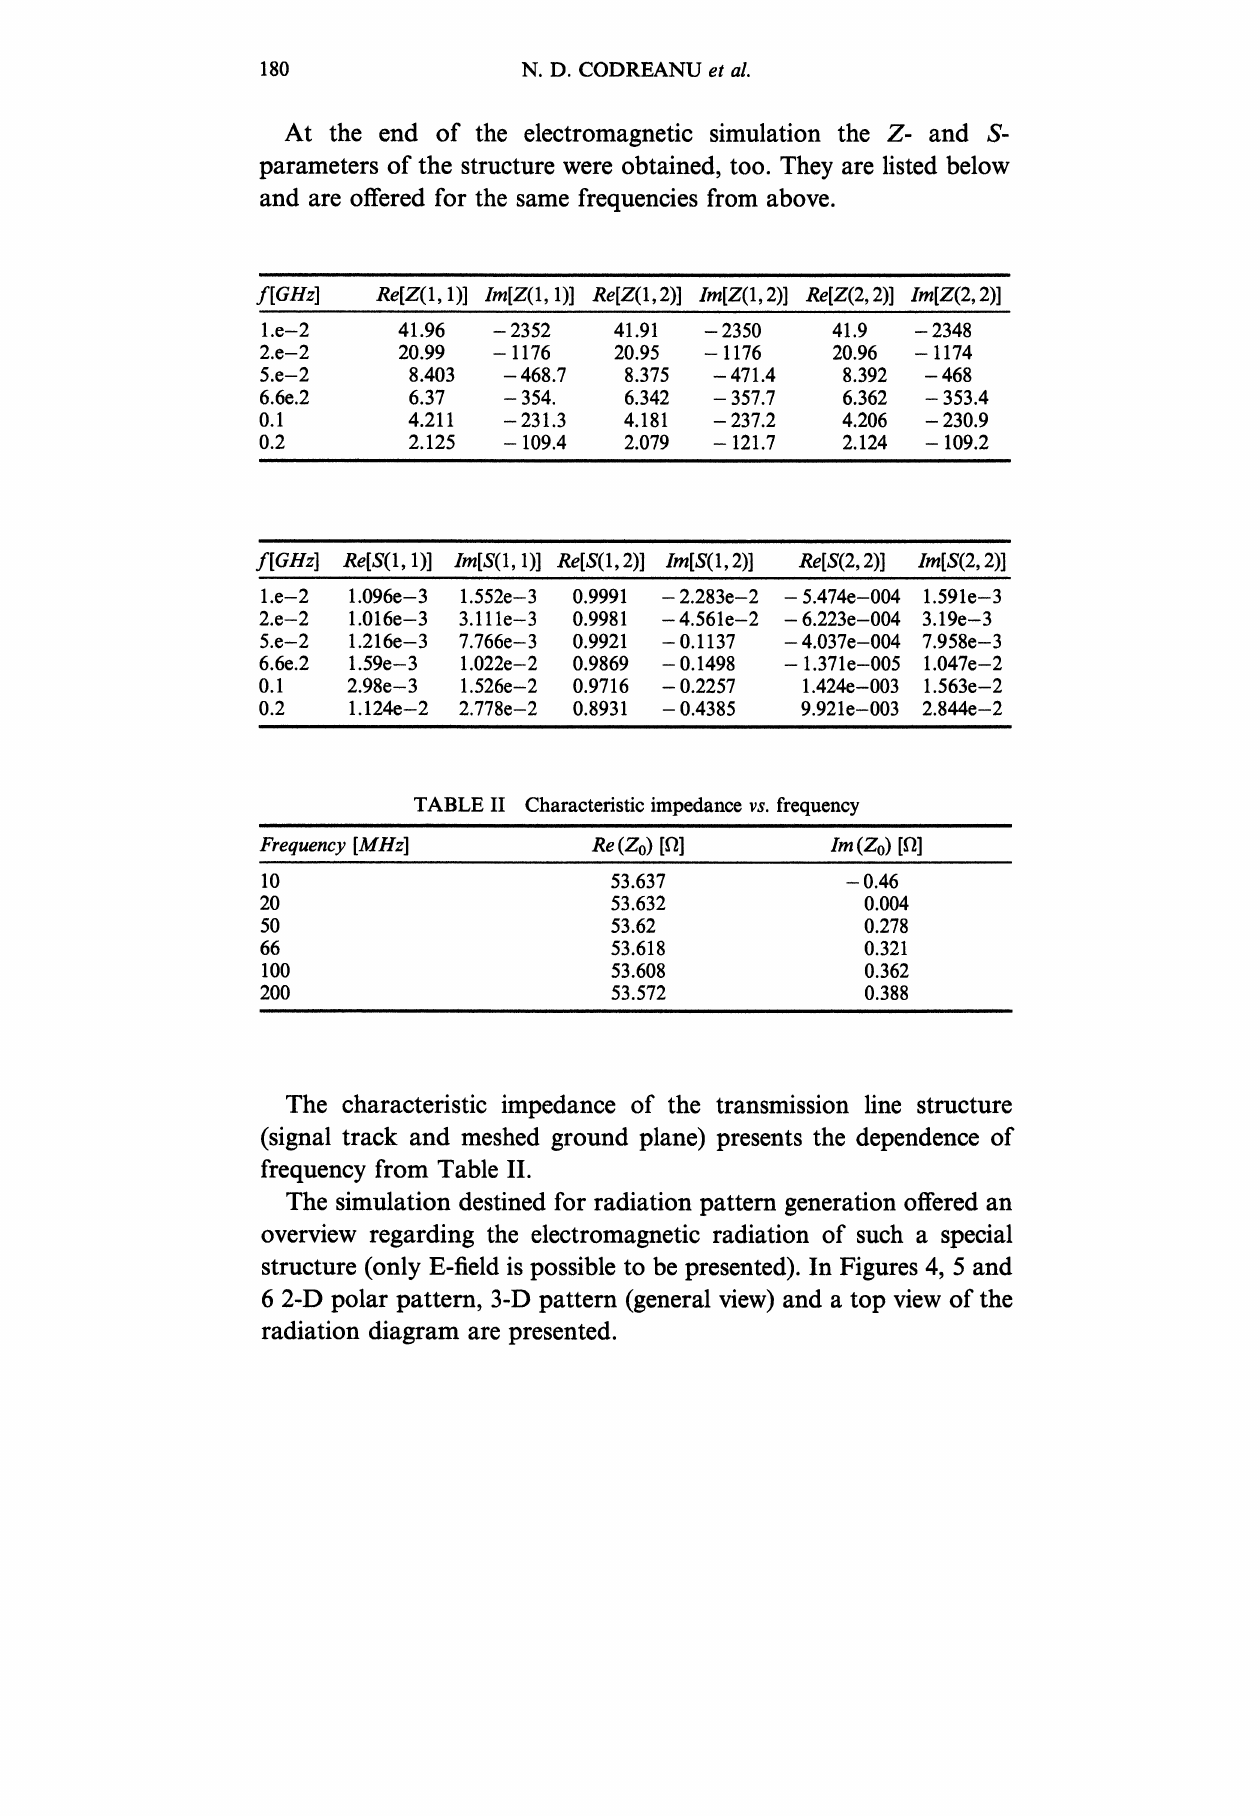
TABLE II Characteristic impedance vs.